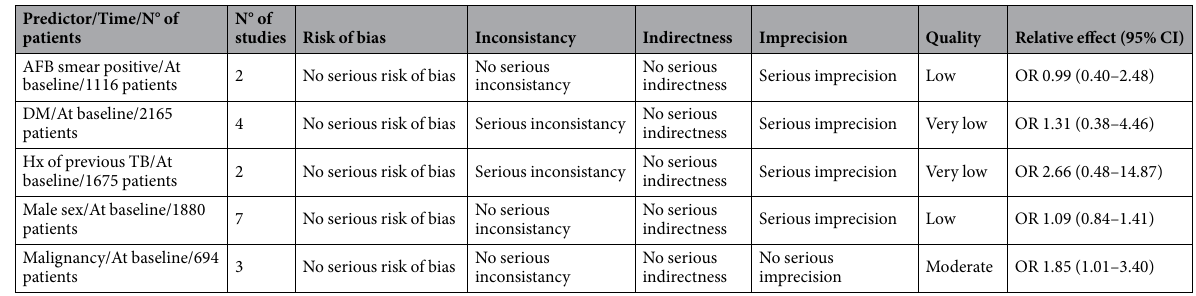
Table 3. GRADE Evidence Profile: Predictors of in-hospital mortality among TB patients. * DM = Diabetes Mellitus; Hx =